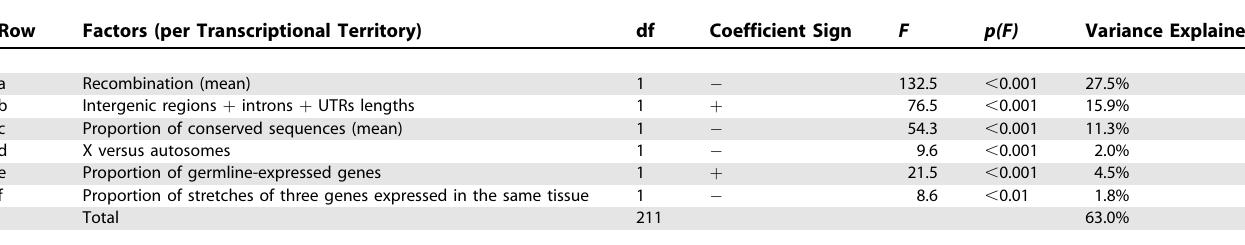
Table 3. Factors Affecting the Total Number of TEs within Transcriptional Territories (GLM) Row Factors (per Transcriptional